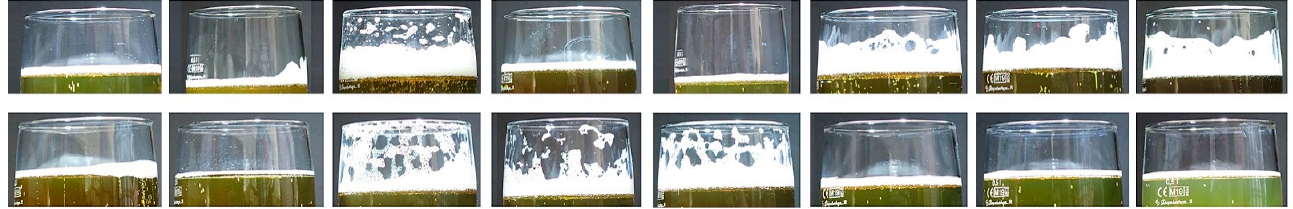
Figure 12. Photos of 16 samples in the last phase of measurement (the first row contains images from samples S01–S08, while the second row contains images from samples S09–S16).